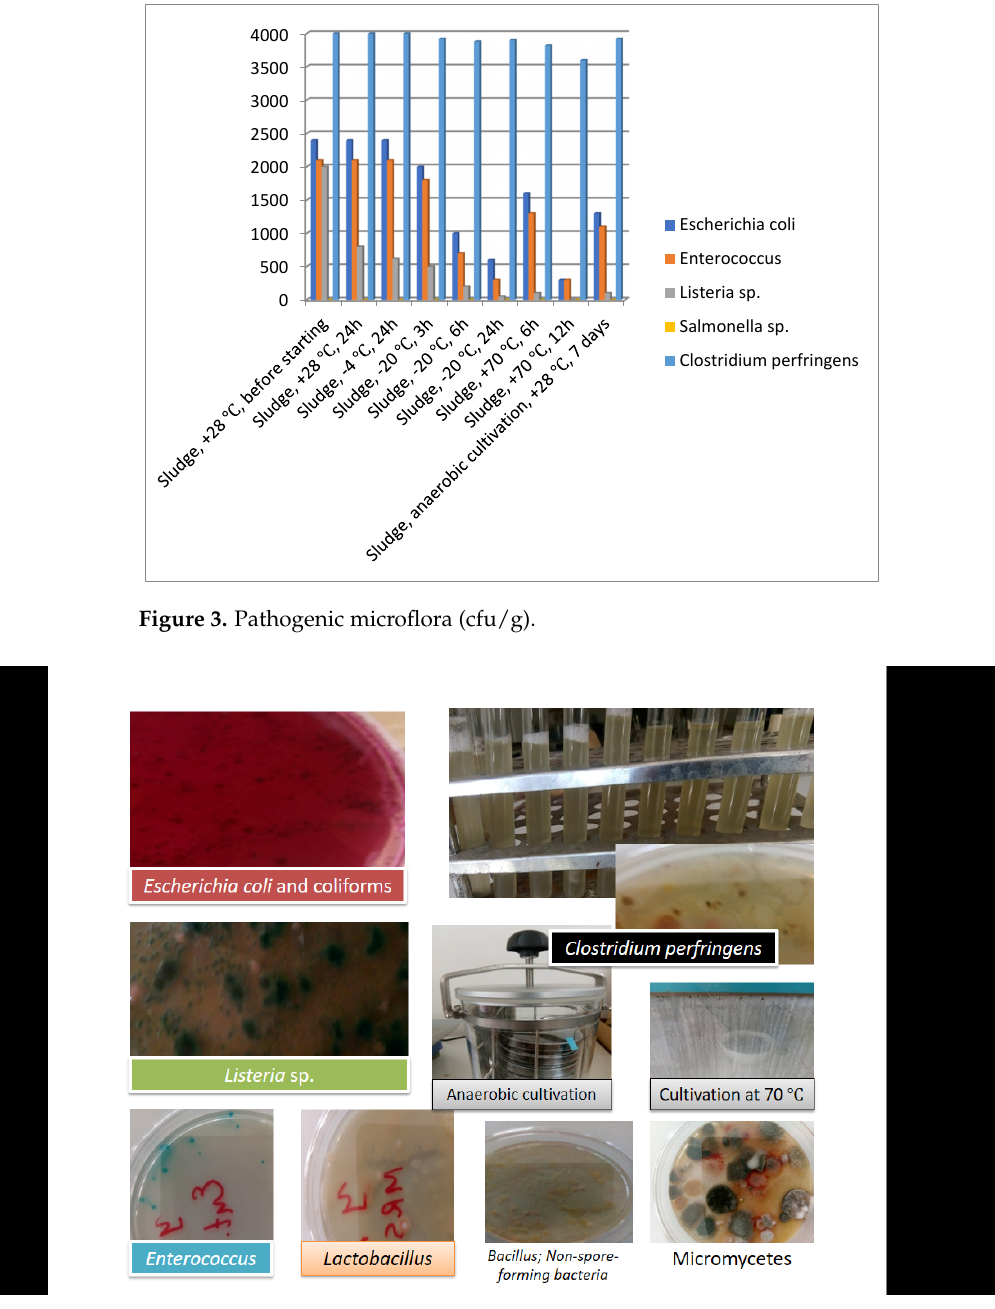
Figure 4. Some isolated microorganisms in the composted variants.